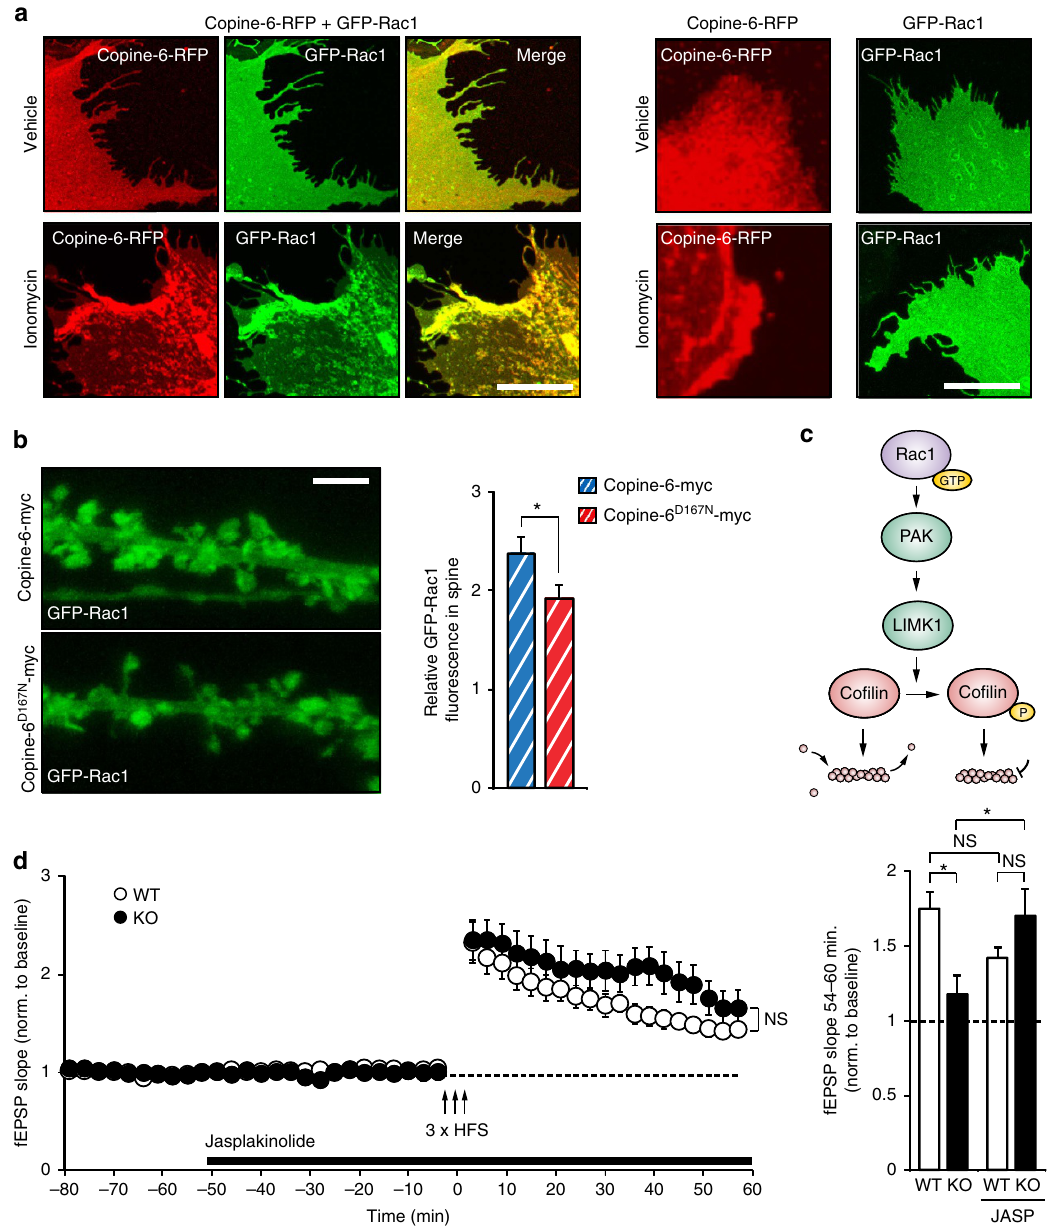
Figure 6 | Copine-6 regulates the dynamics of the actin cytoskeleton. ( a ) COS7 cells expressing the indicated proteins were treated with vehicle or with the calcium ionophore ionomycin. Co-expression of Copine-6-RFP with GFP-Rac1 (left) resulted in the localization of GFP-Rac1 to membranes on ionomycin treatment. In COS7 cells expressing only GFP-Rac1 (right), ionomycin did not affect the cellular localization of GFP-Rac1. Scale bar, 20 m m. ( b ) DIV21 hippocampal cultures, which had been transfected at DIV19 with constructs encoding Copine-6 or Copine-6 D167N together with GFP-Rac1 and tdRFP. Cultures were incubated with cLTP-inducing ACSF for 10min. Right: quantification of the relative GFP-Rac1 intensity in spines after normalization to tdRFP. Data are mean ± s.e.m. from n ¼ 36 spines from 6 neurons per conditions. * P o 0.05 by Student’s t -test. Scale bar, 3 m m. ( c ) Scheme of the Rac1-PAK- LIMK1-Cofilin pathway. ( d ) Extracellular field potential recordings from acute slices of 6- to 8-week-old WT or Cpne6 KO mice. Slices were treated with jasplakinolide during recordings as indicated. LTP was induced by high-frequency stimulation (HFS). Data are mean ± s.e.m. from n ¼ 7 slices and mice per genotype. NS, nonsignificant. P 4 0.05 by two-way ANOVA with Bonferroni post-hoc test. For quantification (right), the mean of the normalized fEPSP slope 54–60min after HFS was compared. Data are mean ± s.e.m. from n ¼ 7–9 recordings per condition (from 6 to 7 mice per genotype, age between 6 and 8 weeks). * P o 0.05; NS, nonsignificant. P 4 0.05 by one-way ANOVA with Tukey’s post-hoc